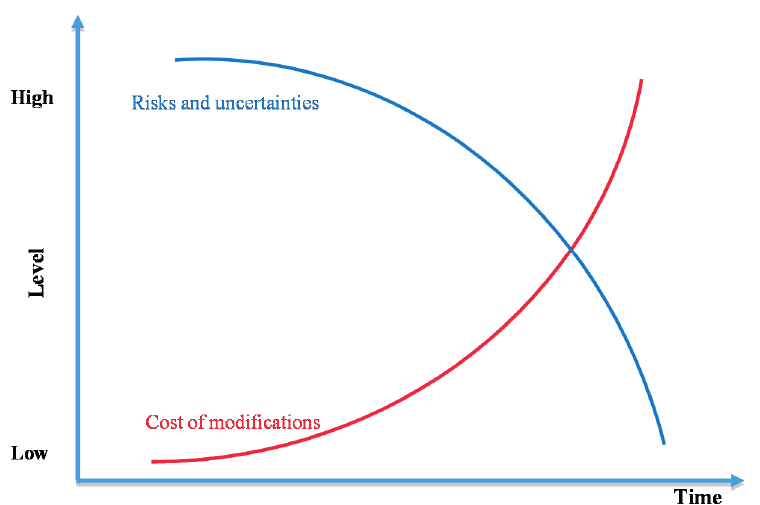
Figure 3. Progression of risks and uncertainties and the cost of modifications, according to the PMBOK ® Guide [11].